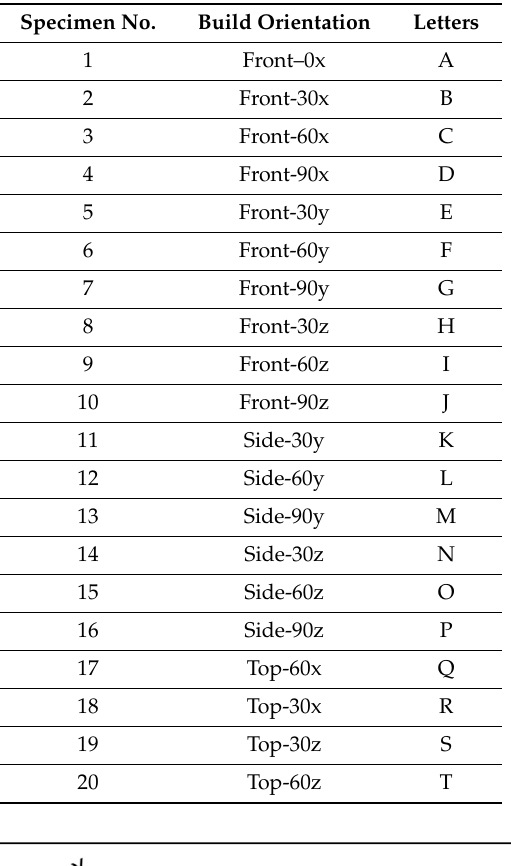
Table 1. Design of experiments.